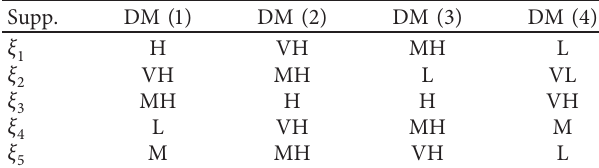
Table 3: The importance weight of the decision attributes.